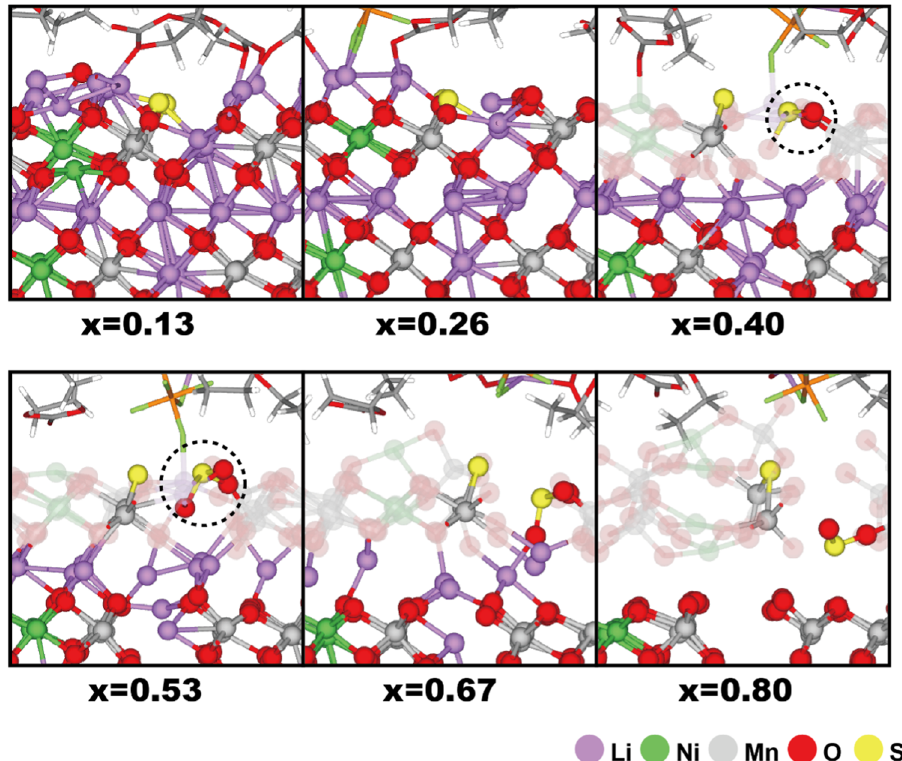
Fig. 4 Optimized con fi gurations for the pristine LNMO system. Side views of snapshot are shown at different delithiation levels (from x = 0.13 to x = 0.8). The black dashed circle represents the position of (SO 2 ) n − /(SO 3 ) m − species on the LNMO surface.